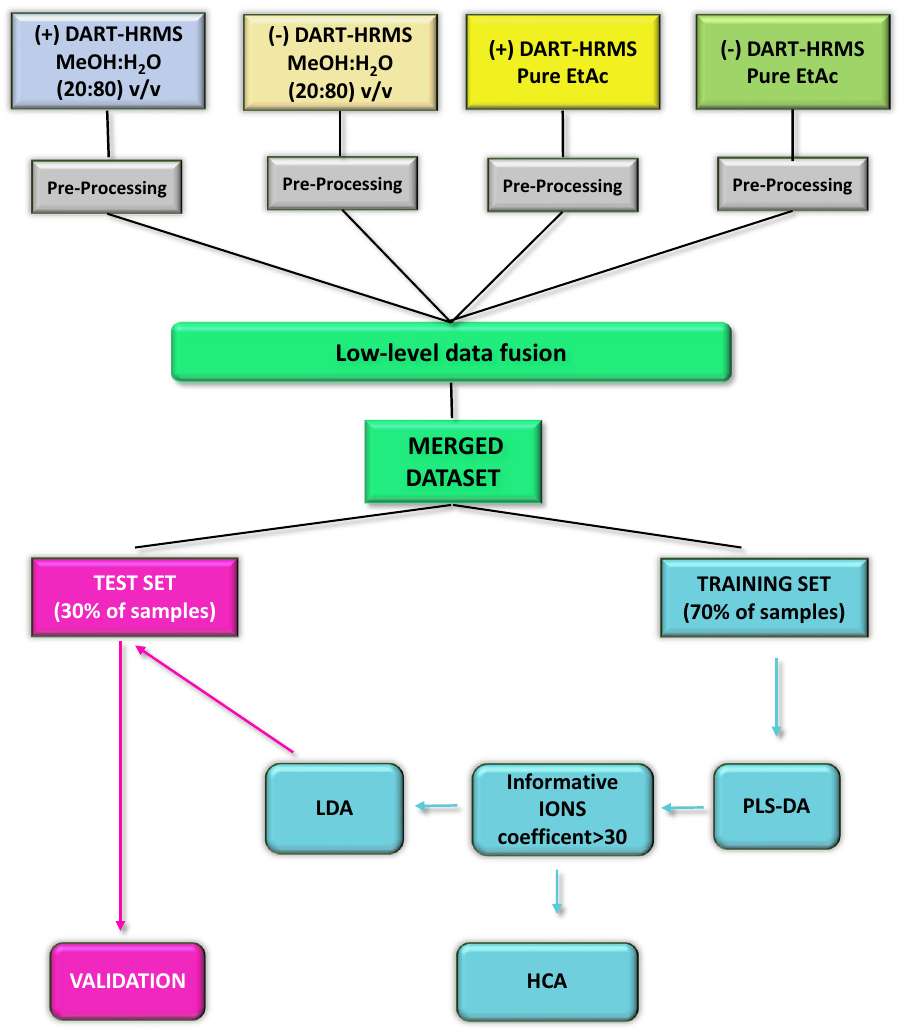
Figure 1. Flow chart of the experimental design and statistical analysis of the (+ / −) DART-HRMS metabolites. After DART-HRMS data pre-processing (TIC normalisation, signal alignment and signal filtering), the four datasets (two dilutions per two ion modes) were submitted to low-level data fusion and the merged dataset was randomly separated into a training (n = 63) and a test (n = 25) set. A partial least squares discriminant analysis (PLS-DA) was performed on the training set and the outcomes were plotted in a scatter gram (see Fig. 2). A hierarchical cluster analysis (HCA) was performed on the 25 selected ions (coefficient > 30) by Pearson distance criterion and generating a heat map (see Fig. 3). The 25 selected ions were used to build a linear discriminant analysis (LDA) model that was validated on the test set (see Table